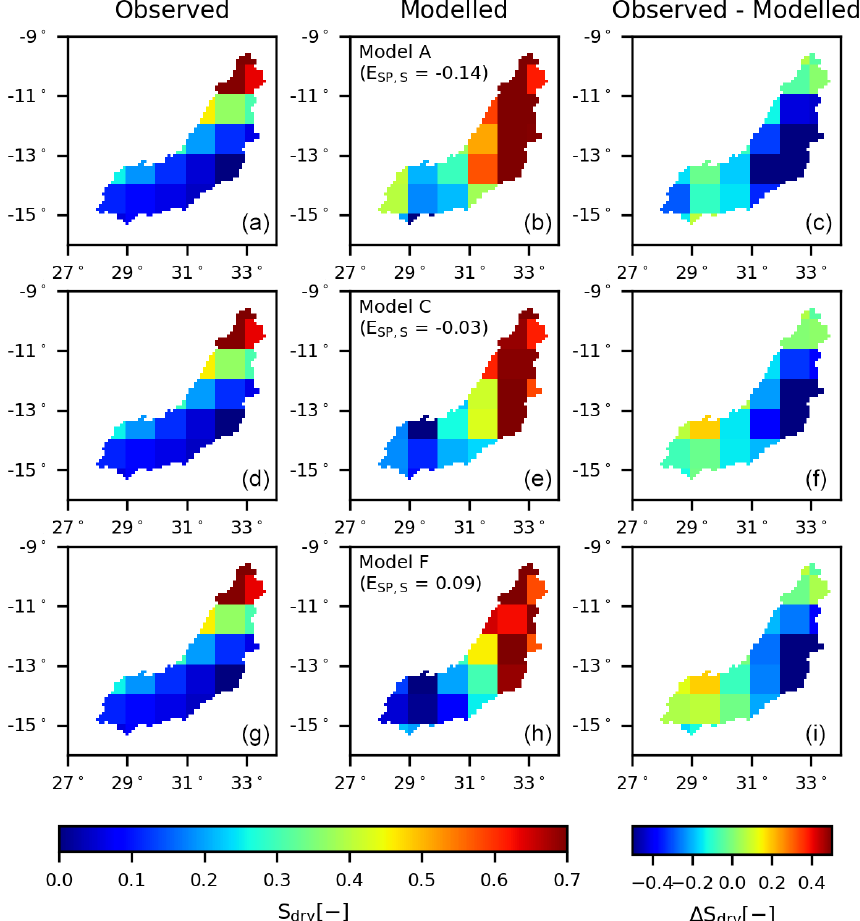
Figure 12. Spatial variability of the normalized total water storage anomalies for Models A, C and F averaged over all days within the dry season. Panels (a, d, g) show the observation according to GRACE data, (b, e, h) the model result using the “optimal” parameter set with respect to multiple variables ( D E , ES Q cal ) and (c, f, i) the difference between the observation and